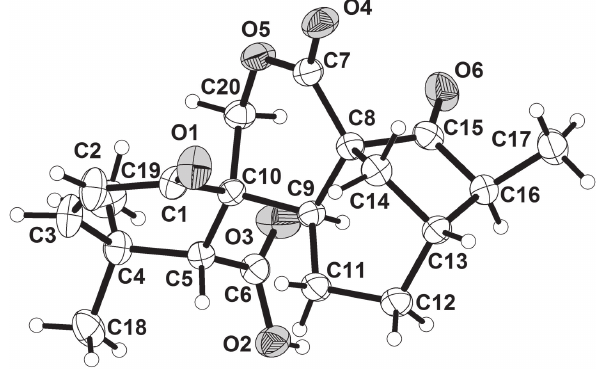
Table 2: Fractional atomic coordinates and isotropic or equivalent isotropic displacement parameters (Å 2